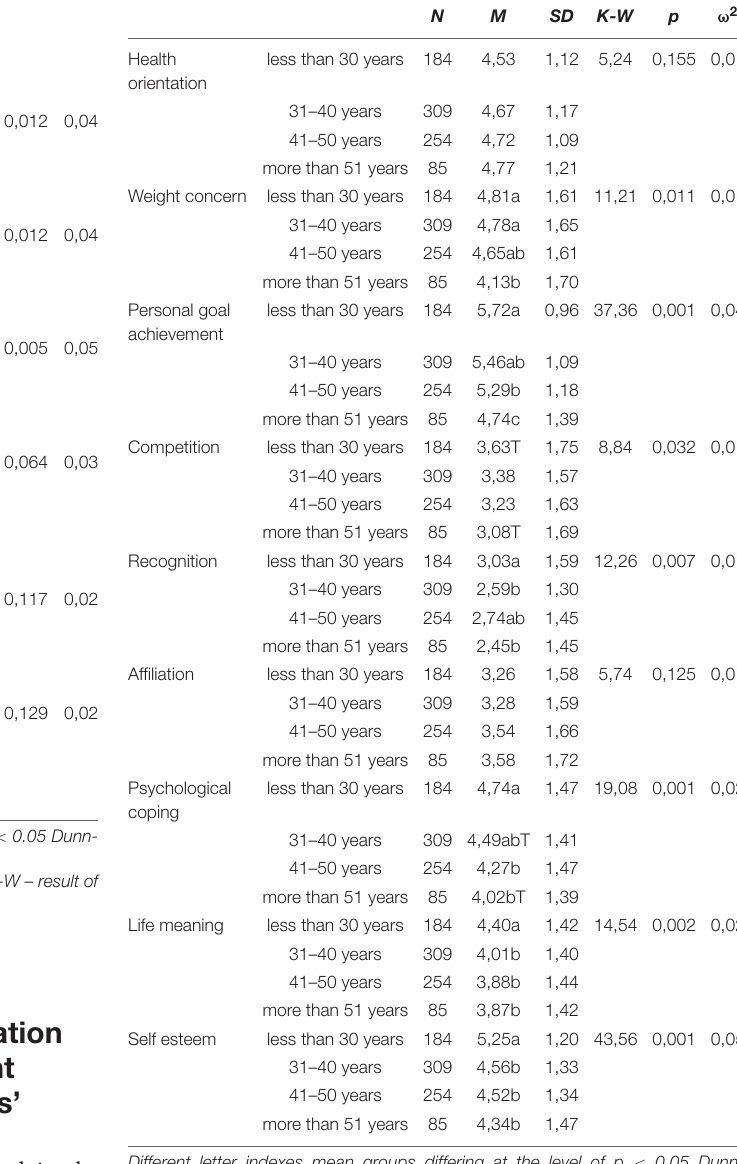
TABLE 3 | Comparison of the level of motivation scales of marathon runners not competing in ultramarathons in different age groups.